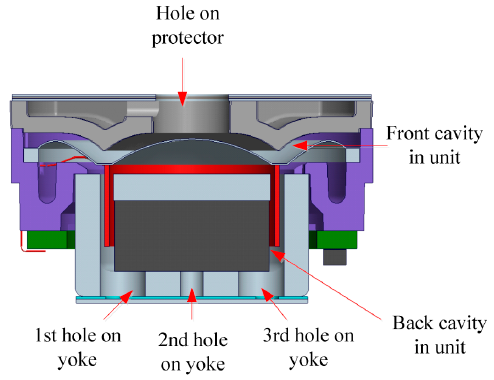
Figure 3. Equivalent circuit of mechanical domain.